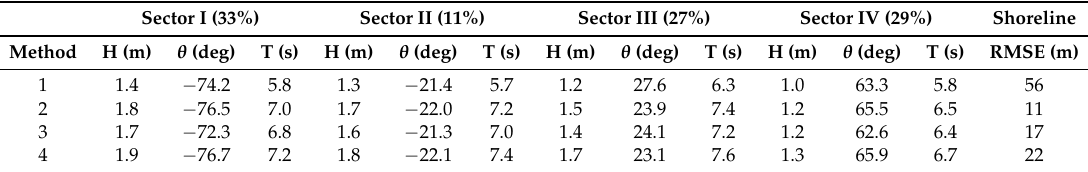
Table 1. Sensitivity to the statistical method that synthesizes the RWC into four directional sectors, where H is the significant wave height, T is the peak wave period, and θ is the wave direction measured with respect to the shore normal. The frequency of occurrence of each sector is written between brackets. The last column shows the shoreline RMSE (with respect to RWC) at the end of the simulations (average over Years